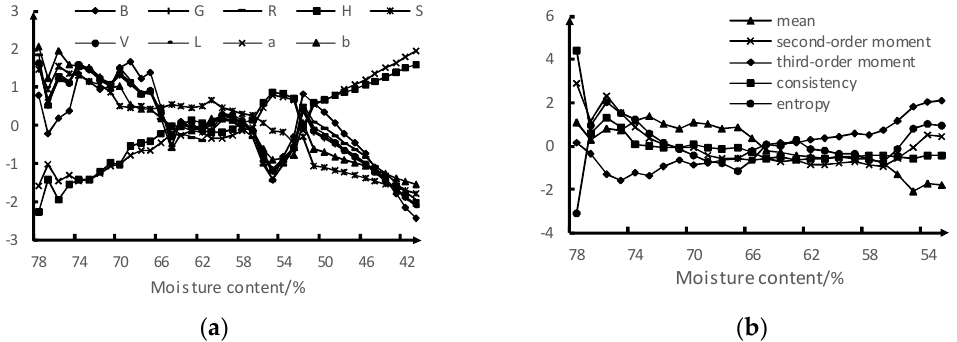
Figure 6. Relationship between the moisture content and image features: ( a ) Variation trend of the color features; ( b ) variation trend of the texture features.